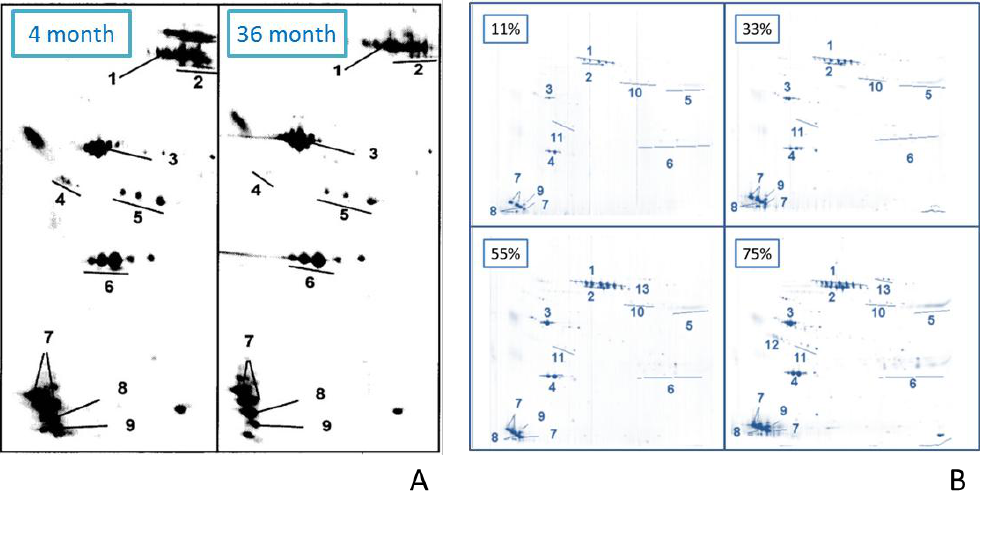
Figure 8. Influence of age and incubation time on adsorption patterns. ( A ) Close-ups of 2-DE gels four months stored and 26 months stored propofol loaded emulsion showing the lower left part, ranging from isoelectric point 4.4 (left gel side) to 5.7 (right gel side) and molecular weight 200 kD (upper gel area) to 6 kD (lower gel area). Protein spot number: (1) IgD, (2) Albumin, (3) ApoA-IV, (4) ApoJ, (5) ApoE, (6) ApoA-I, (7) ApoC-III, (8) ApoC-II, (9) ApoA-II (modified after [126]); ( B ) Protein adsorption pattern of Lipofundin MCT 20% oil-in-water emulsion incubated with different plasma concentrations (11%, 33%, 55%, 75%) (modified after [79]). Protein spot number: (1) Immunoglobulin D chain, (2) Albumin, (3) Apolipoprotein (Apo) A-IV, (4) Apo A-I, (5) Immunoglobulin g heavy chains, (6) Immunoglobulin light chains, (7) Apo C-III, (8) Apo C-II, (9) Apo A-II fragment, (10) Apo H, (11) Apo E, (12) Apo J, (13) Complement factor C3